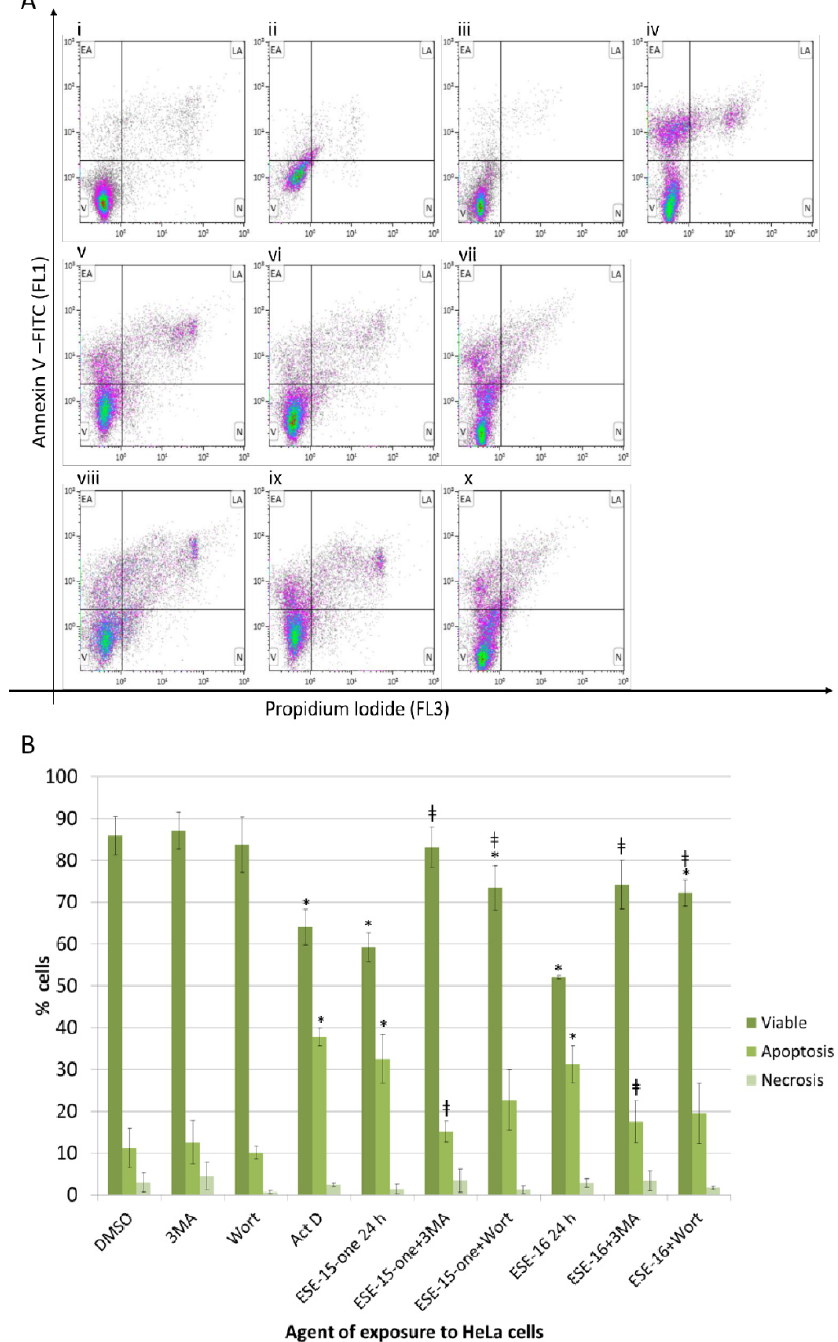
Figure 9. Effect of autophagy inhibition on apoptosis induction in response to the 2ME-analogues. ( A ). Representative Annexin V-FITC scatter plots of HeLa cells exposed to the compounds in the presence or absence of autophagy inhibition. Cells exposed to DMSO (i), 3MA (ii) and wortmannin (iii) were negative controls. Actinomycin D (iv) was the positive apoptosis control. ESE-15-one exposure for 24 h (v) resulted in a decrease in viable cells with a concomitant increase in apoptotic cells. This response was attenuated in the presence of 3MA (vi) and wortmannin (vii). ESE-16-exposure (viii) demonstrated a similar response, again muted in the presence of 3MA (ix) and wortmannin (x). (V = viable cells; EA = early apoptosis; LA = late apoptosis; N = necrosis). ( B ). Graphical representation of the scatterplots. Standard deviation indicated by error bars; * p < 0.05 when compared to the DMSO vehicle control; ‡ p < 0.05 when autophagy-inhibited samples were compared to the relevant drug-exposed samples.